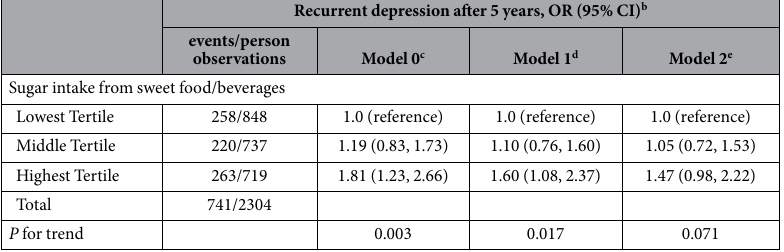
Table 4. Prospective association of sugar intake from sweet food/beverages and recurrent depression after 5 years a . Abbreviations: OR = Odds ratio, CI = Confidence interval, DASH = Dietary Approaches to Stop Hypertension, CVD = cardiovascular disease. a Prospective association across phases 7, 9 for recurrent depression. b Depression measured using 20-item the Centre of Epidemiologic Studies Depression Scale. c